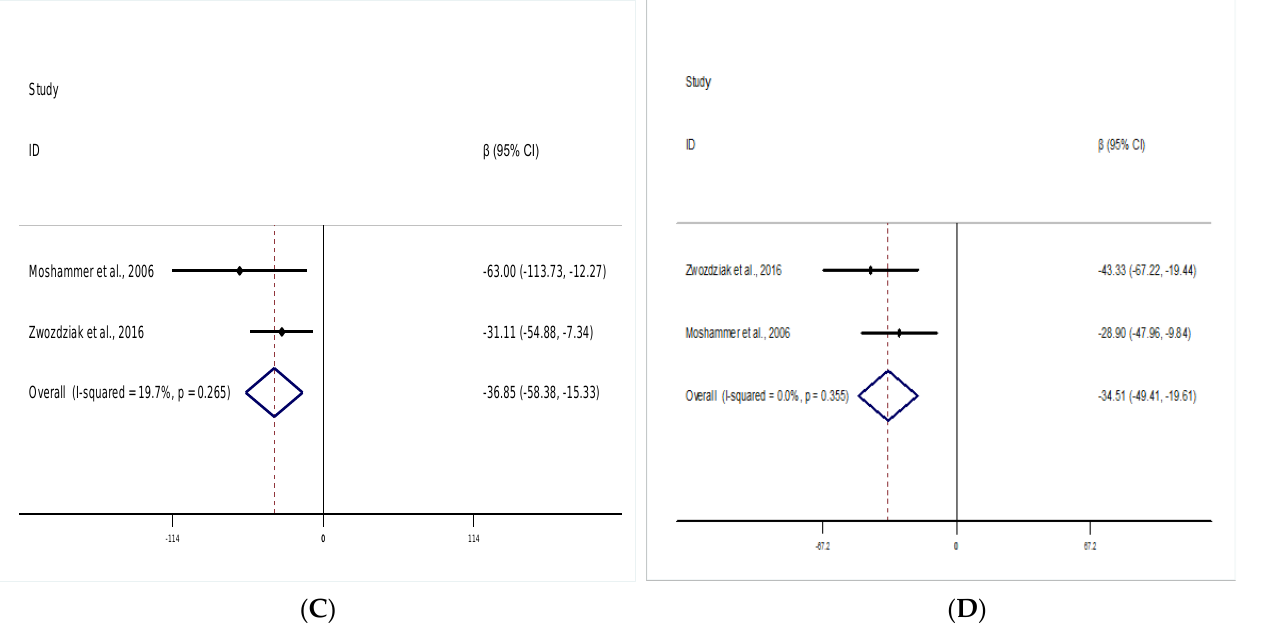
Figure 2. Forest plot of the meta- analysis: per 10 μg/m 3 increase of PM 1 was associated with pooled β values of lung function indicators in the short -term group: ( A ) FVC, ( B ) FEV 1 , ( C ) PEF, ( D ) MMEF [31,32,36]. The open diamonds represent the combined β value for each group. The solid line repre- sents β value = 0.